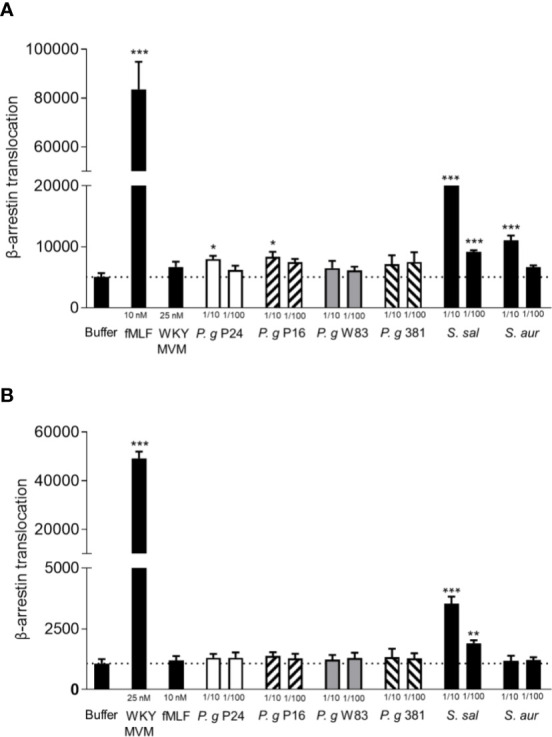
P. gingivalis supernatants of do not activate FPR1 or FPR2. Activation of FPR1 and FPR2 was measured as the ability of bacterial culture supernatants to stimulate recruitment of β-arrestin in CHO cells overexpressing FPR1 and FPR2 respectively, and β-arrestin recruitment was quantified using an enzyme fragment complementation assay. Two experiments were performed with the same cell line, and each condition was analyzed in triplicates. (A) Culture supernatants of the two P. gingivalis lab strains (W83, 381) (1:10, 1:100) did not stimulate β-arrestin recruitment in cells expressing FPR1, while supernatants of the clinical isolates of P. gingivalis (P24, P16) showed slight FPR1 activity in the higher concentration (1:10). The FPR1 agonist fMLF (10 nM) and control supernatants of S. salivarius and S. aureus did stimulate β-arrestin recruitment (mean + SD). (B) Culture supernatants of the four P. gingivalis strains (1:10, 1:100) and S. aureus (1:10, 1:100) did not stimulate β-arrestin recruitment in cells expressing FPR2, while FPR2 agonist WKYMVM (25 nM) and control supernatant of S. salivarius (1:10, 1:100) did stimulate β-arrestin recruitment (mean + SD). Statistics were calculated as 6 technical repeats and Kruskal-Wallis test followed by Dunn´s multiple comparison test was used to analyze significant differences. *<0.05, **< 0.01, ***< 0.001.